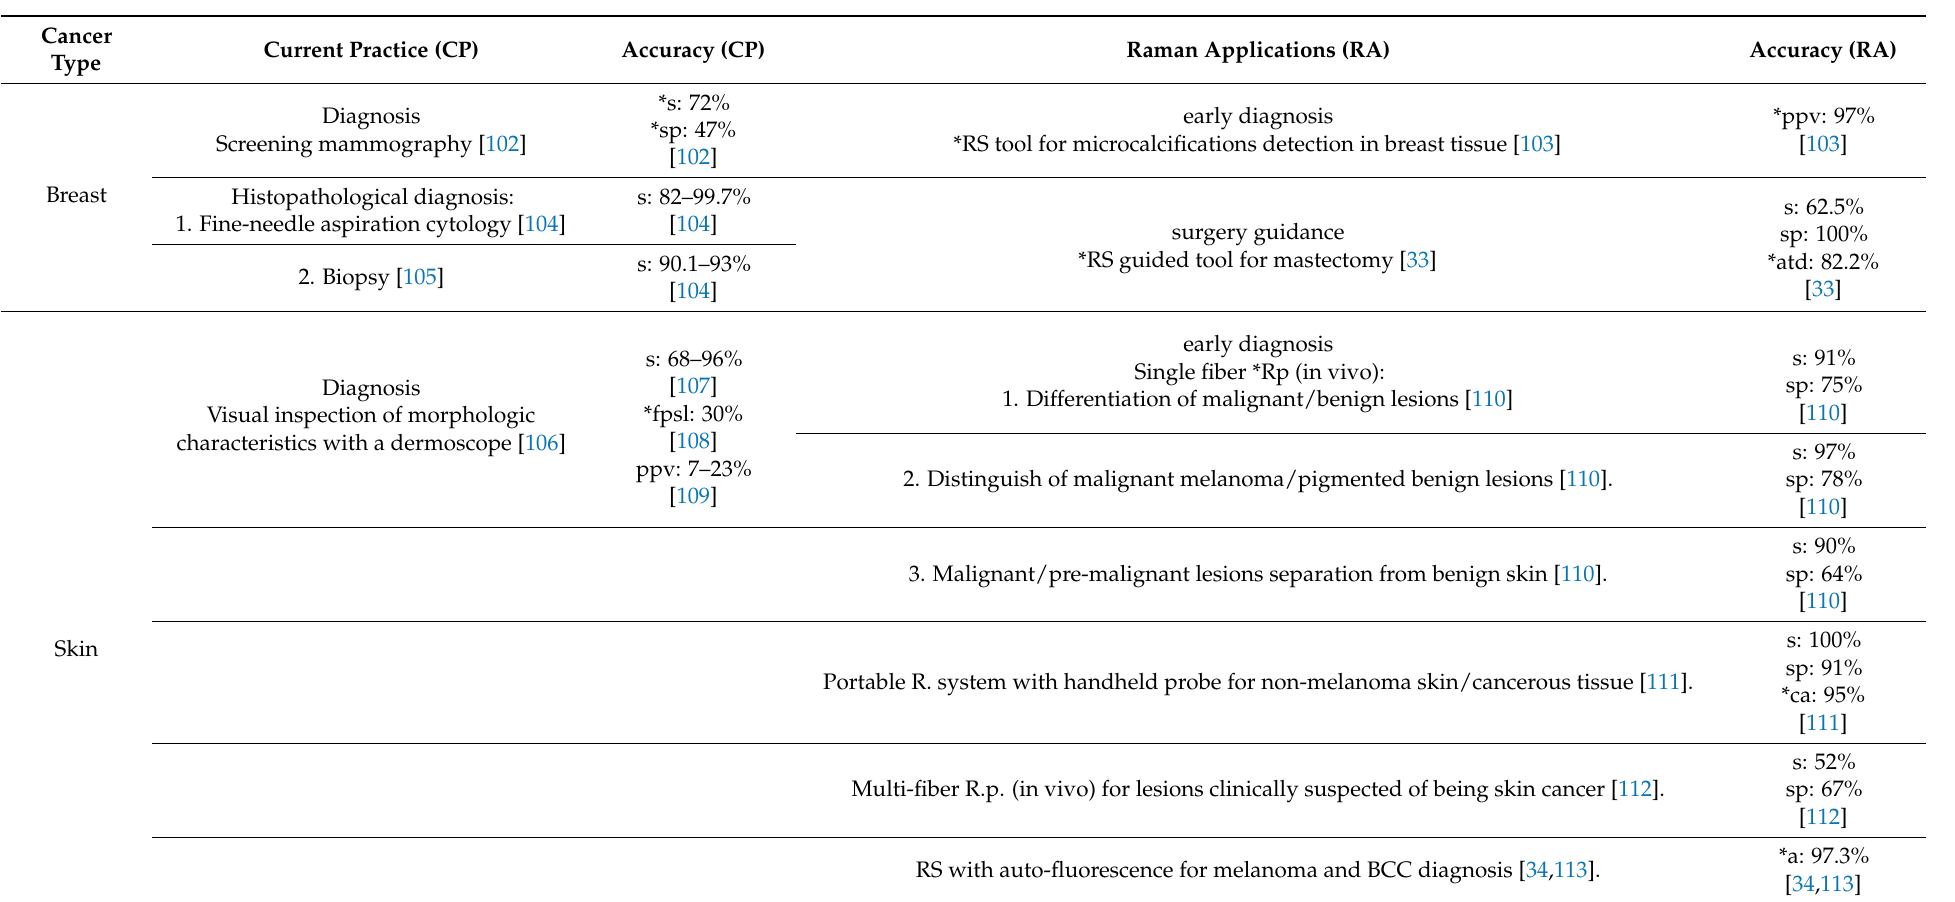
Table 1. Clinical Raman applications for diagnosis and surgery